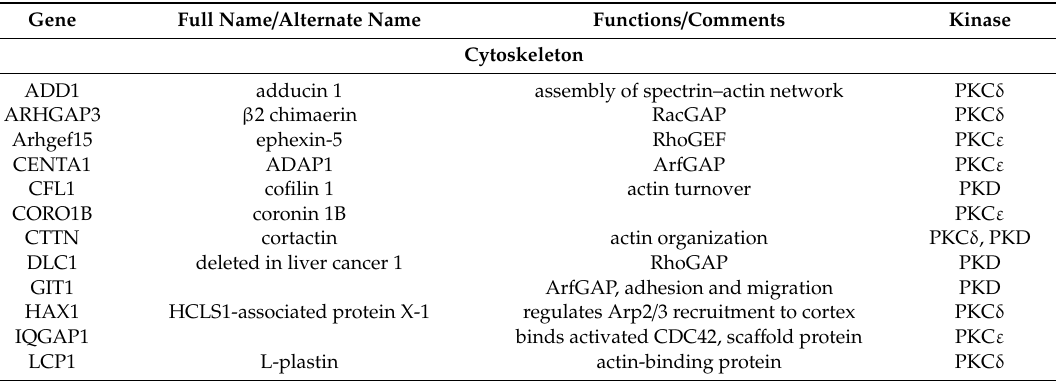
Table 1. nPKCs and PKD substrates related to the cytoskeleton and adhesive